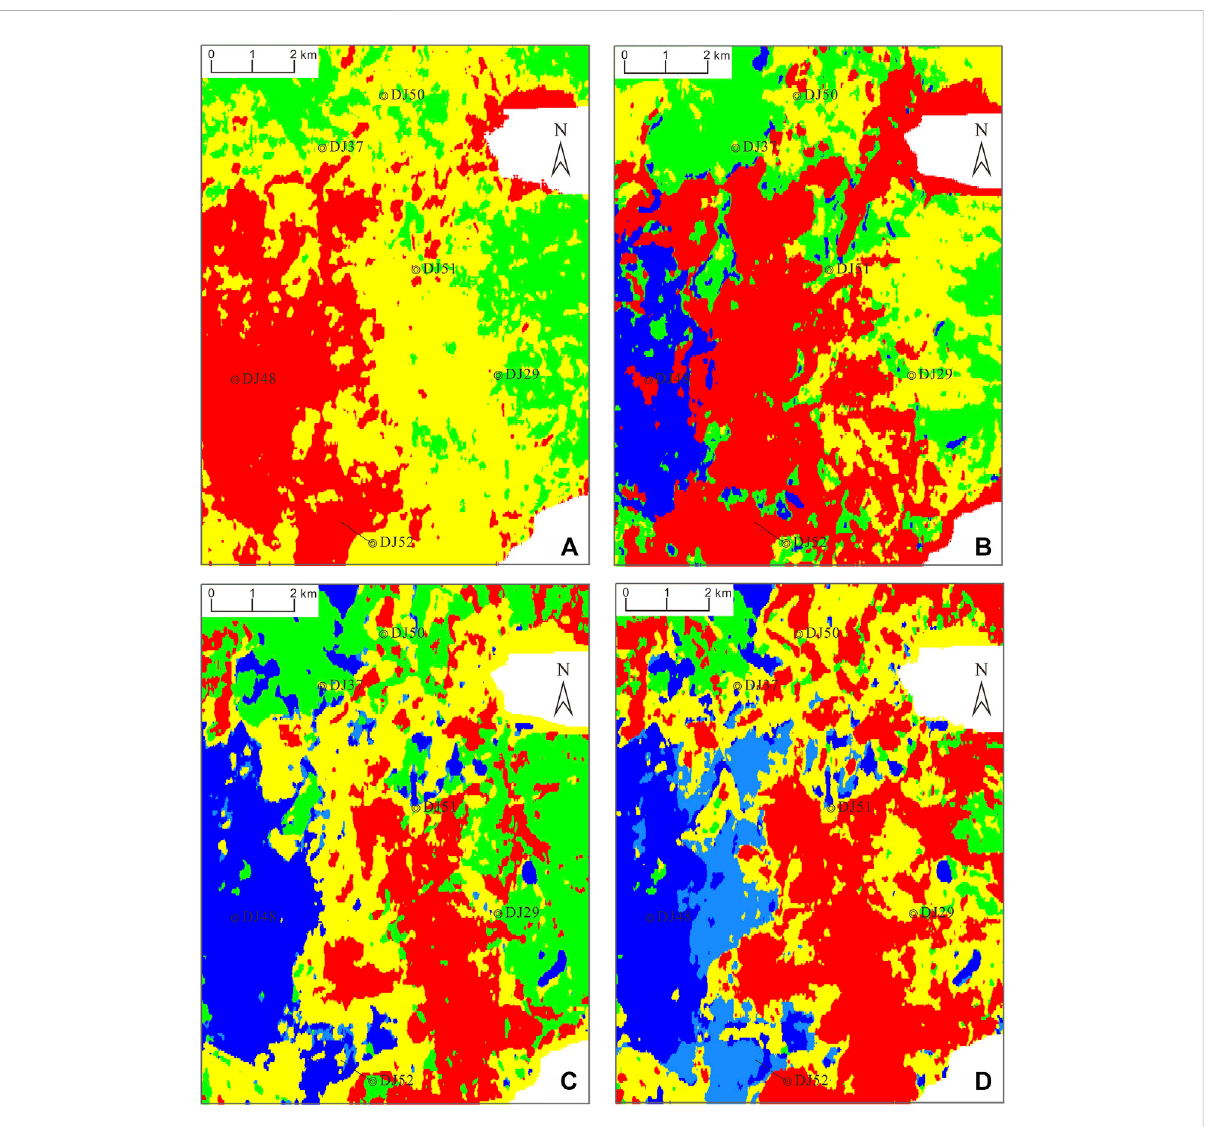
FIGURE 11 Seismic facies plane distribution of each section in the Shan-2 Lower Sub-member in the eastern Ordos Basin: (A) Section 4; (B) Section 3; (C) Section 2; (D) Section